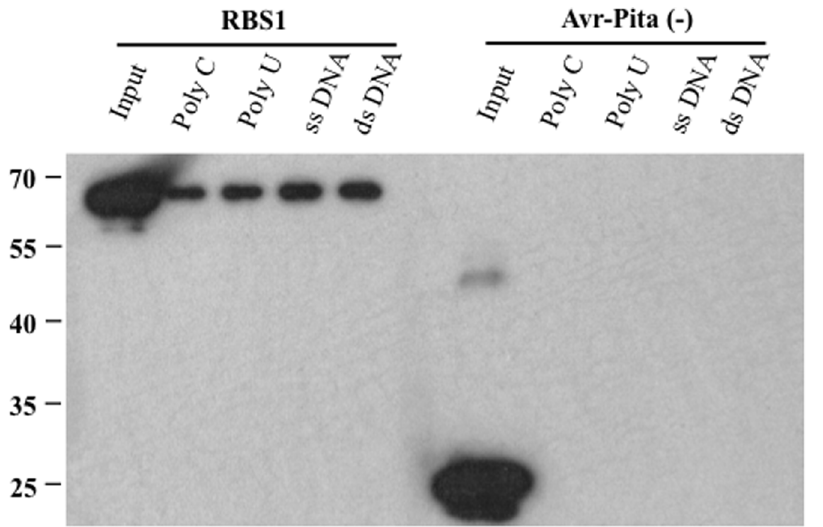
Figure 4. RNA and DNA binding assay for RBS1. E. coli- purified 6xHis-RBS1 protein was incubated with ribohomopolymers, ssDNA and dsDNA to test for in vitro nucleic acid binding activity. An unrelated protein, 6xHis-Avr-Pita was used as a negative control. Proteins were detected by western blot using an Anti-His antibody.